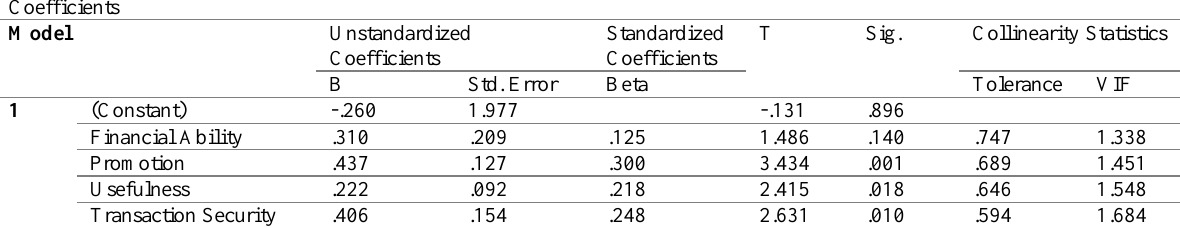
Table 9: Multicollinearity Test